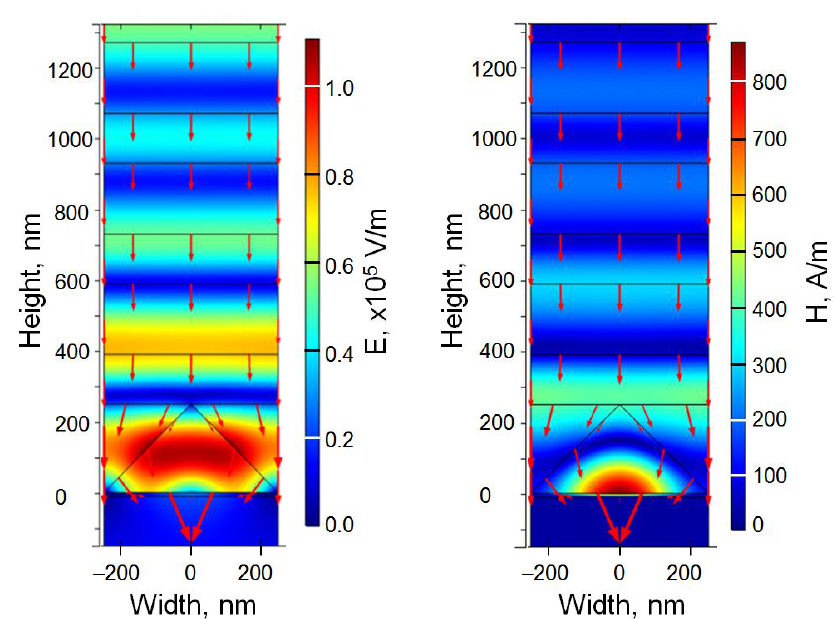
Figure 4. Spatial distribution of the electric ( left image ) and magnetic ( right image ) fields for TM polarization at 940 nm at the cross-section with an embedded blazed diffraction grating (as shown in Figure 1b). Red arrows represent the power flow.